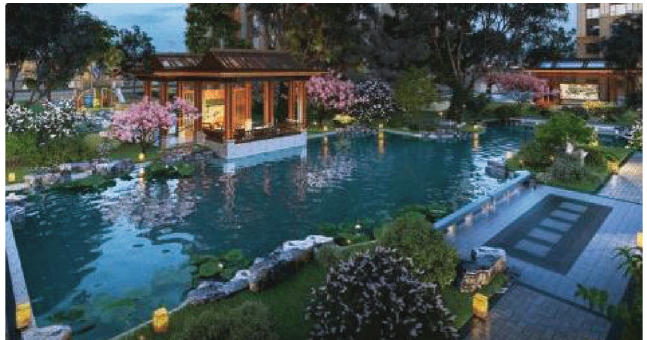
Figure 1: “ Chinese and new ” architectural style.